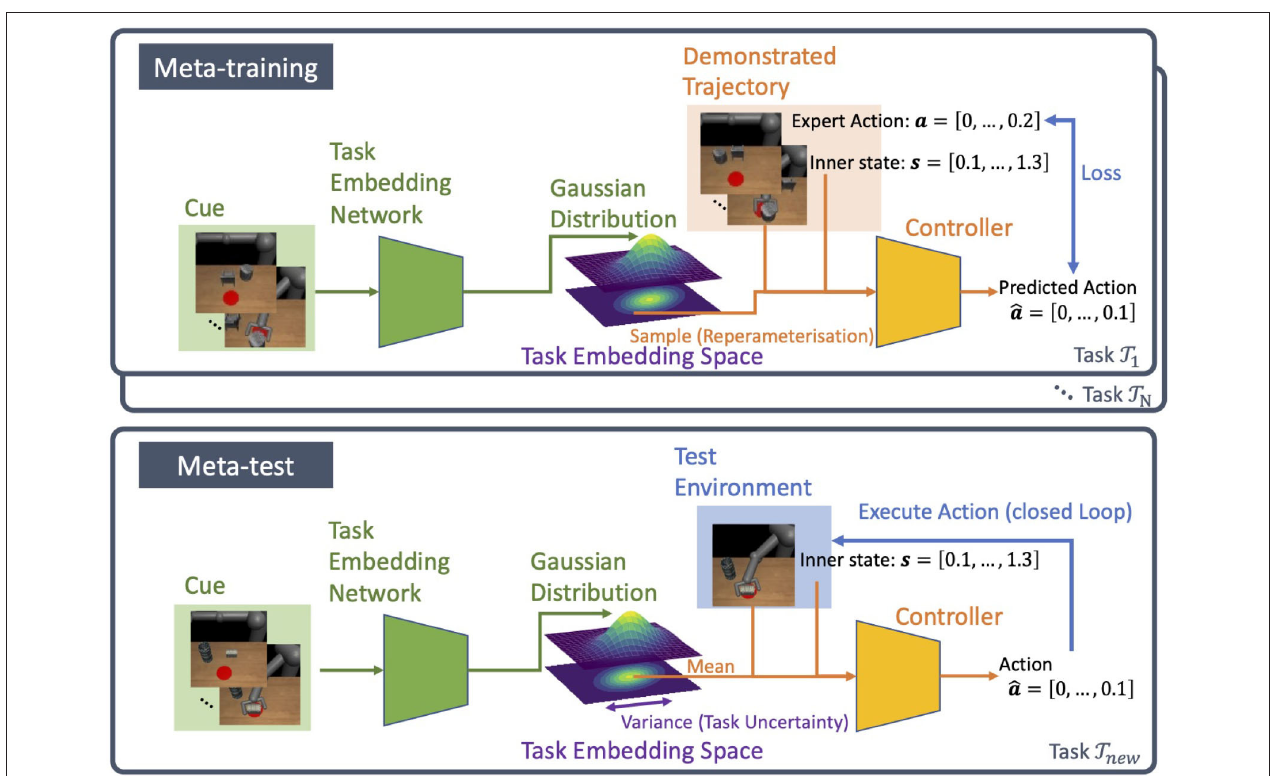
FIGURE 1 | Overview of PETNet. The model consists of two neural networks, task embedding network and controller. During meta-training, the latent task variable is sampled from the distribution over task embedding. In the meta-test, the variance is the measurement of task